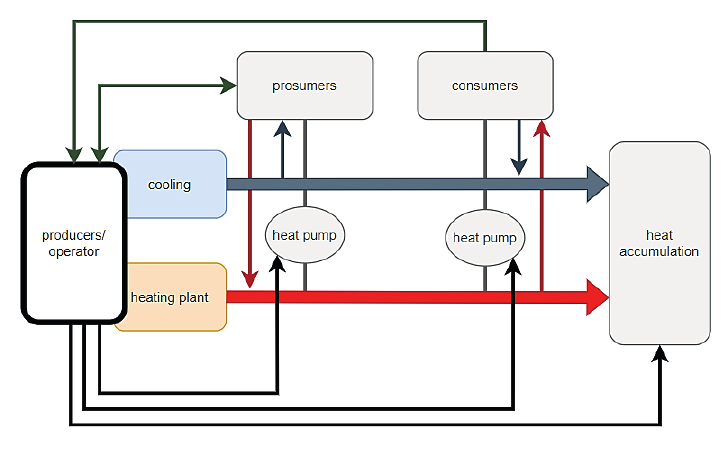
Fig. 3. Scheme of Scenario 1b. Thermal Energy Purchase Agreement without external heat producer